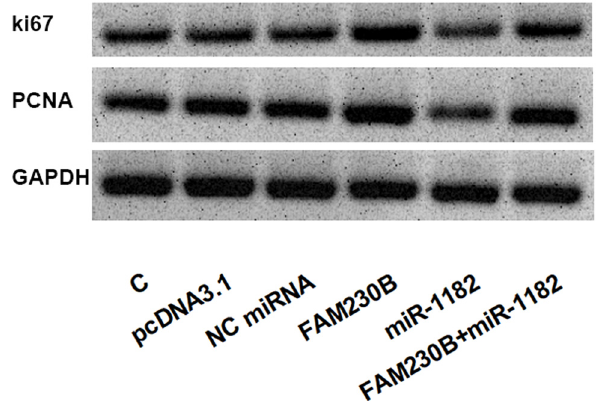
Figure A1: Expression of cell proliferation markers ki67 and